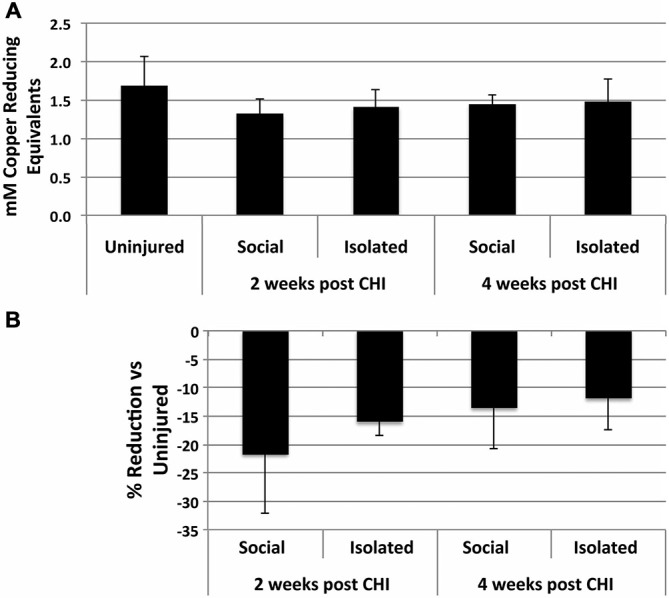
CHI reduced total antioxidant capacity in brain tissue. (A) Presents the mean antioxidant capacity ± standard deviation in mM copper reducing equivalents in for homogenates from brain tissue of uninjured mice and mice housed socially or individually for 2 and 4 weeks after CHI as indicated (n = 3 for each condition). (B) Presents the % reduction (± standard deviation) in antioxidant capacity for homogenates from brain tissue from mice subjected to CHI vs. uninjured mice. Mice subjected to CHI displayed decreases from 10–20%; these decreases did not differ significantly from those of mice not subjected to CHI (p = 0.26; ANOVA).